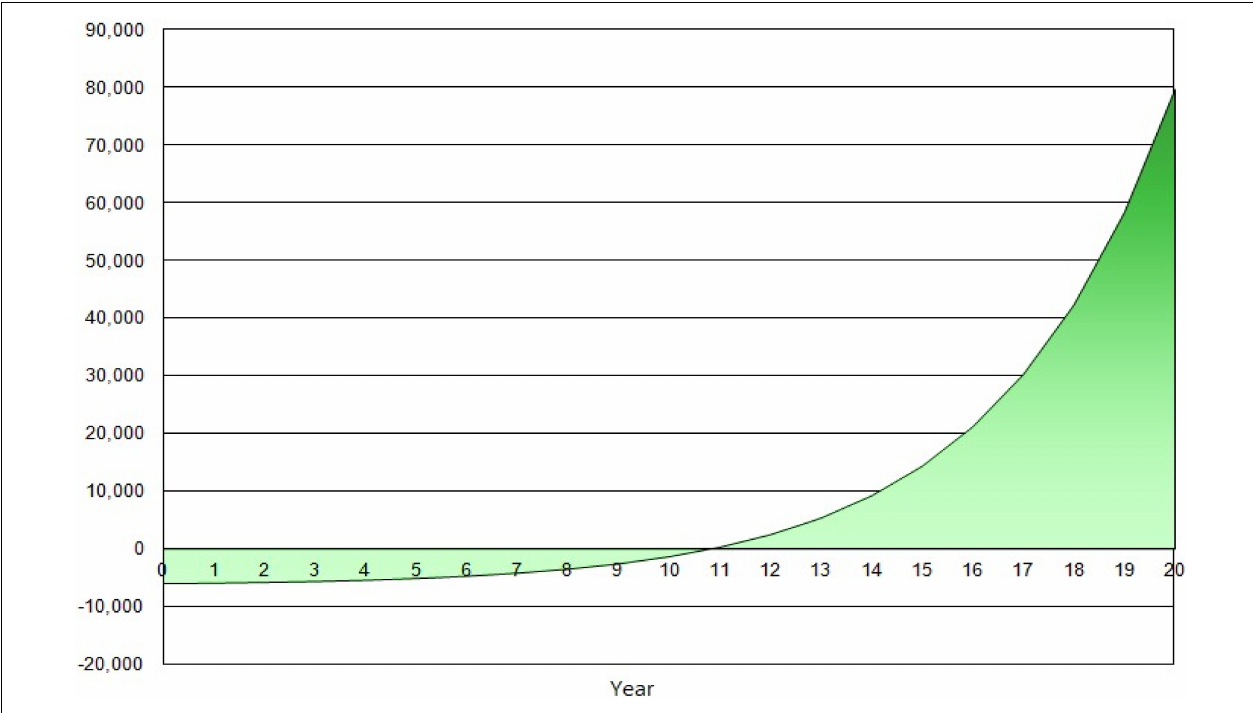
FIGURE 2 | Diagram of cash